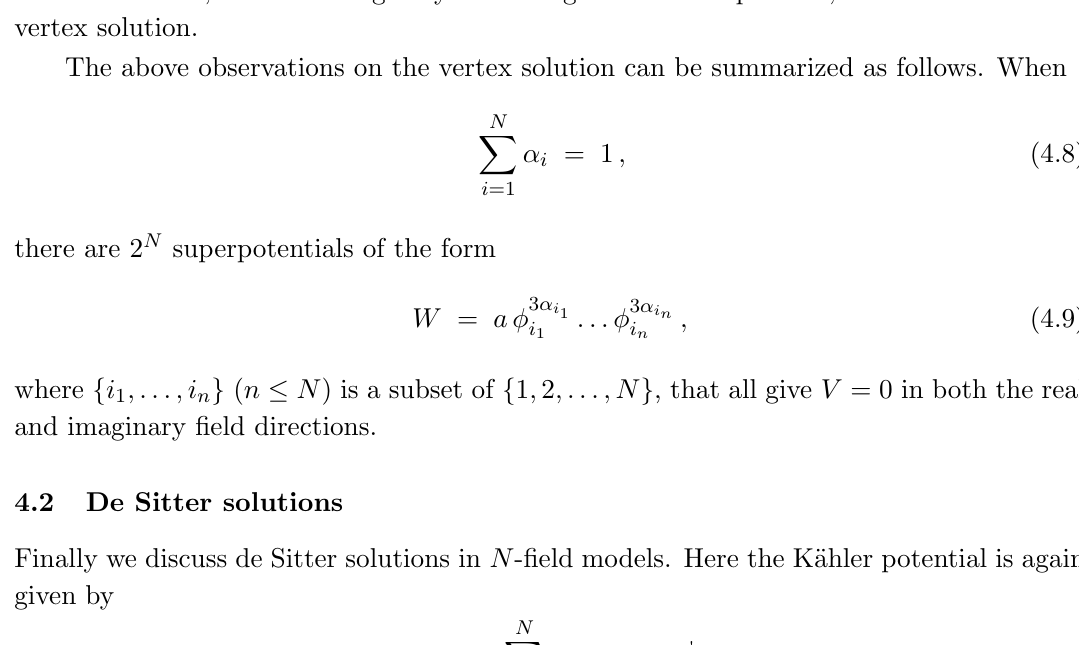
Figure 6 . Allowed values of (cid:11) 1 ; (cid:11) 2 ; (cid:11) 3 for a three-(cid:12)eld model with ~r = (1 = 2 N unit vectors, each di(cid:11)ering only in the sign of the components, that have the same vertex